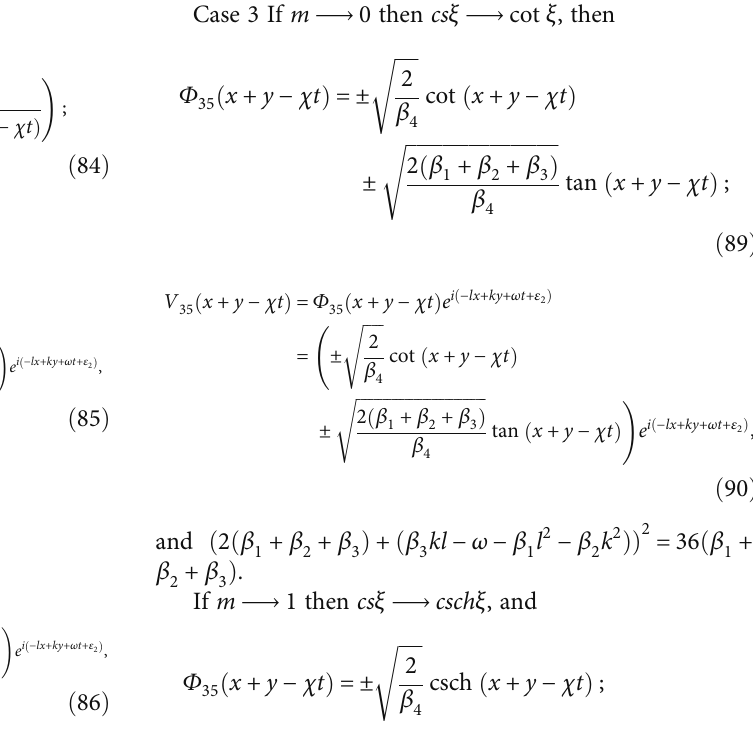
ffiffiffiffiffiffiffiffiffiffiffiffiffiffiffiffiffiffiffiffiffiffiffiffiffiffiffi β + β ð 1